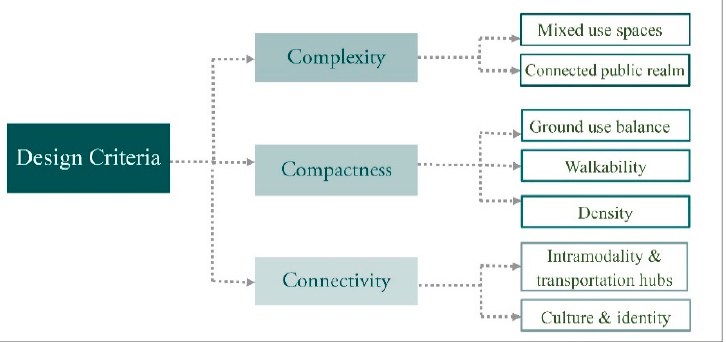
Figure 9. The design criteria used in the site analysis and design proposal (Source: the Authors).